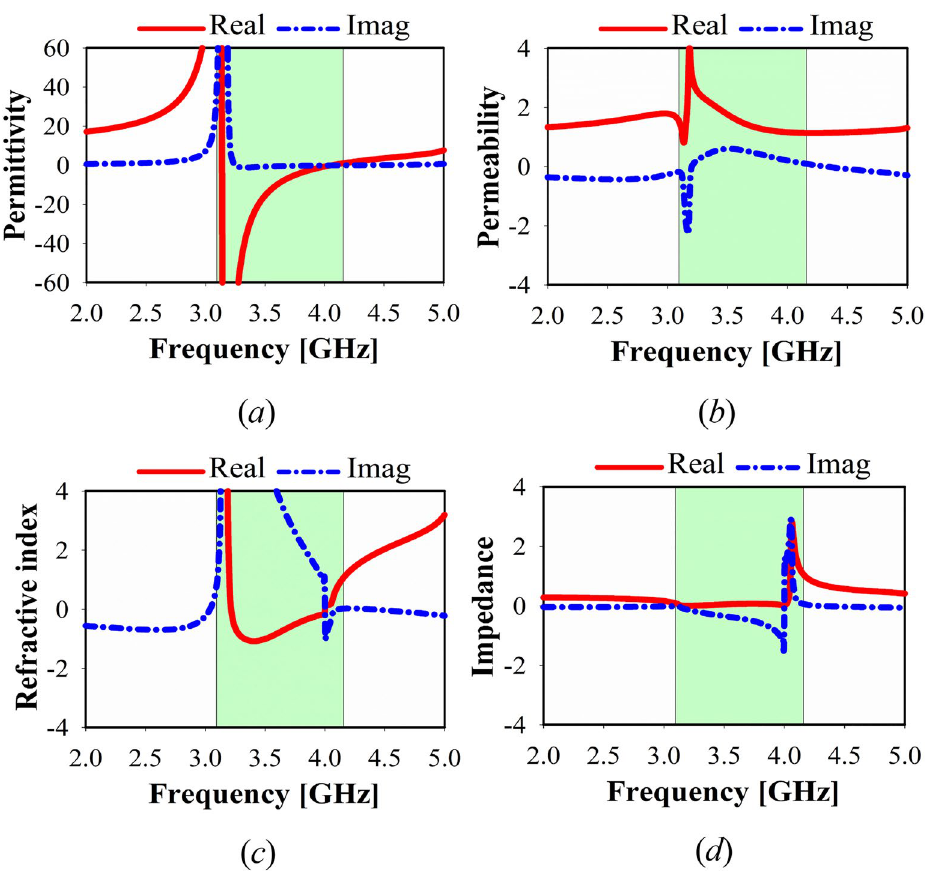
Figure 5. MTM, simulated results at z-axis of 1 × 1 unit cell: ( a ) permittivity, ( b ) permeability, ( c ) refractive index, ( d ) impedance.